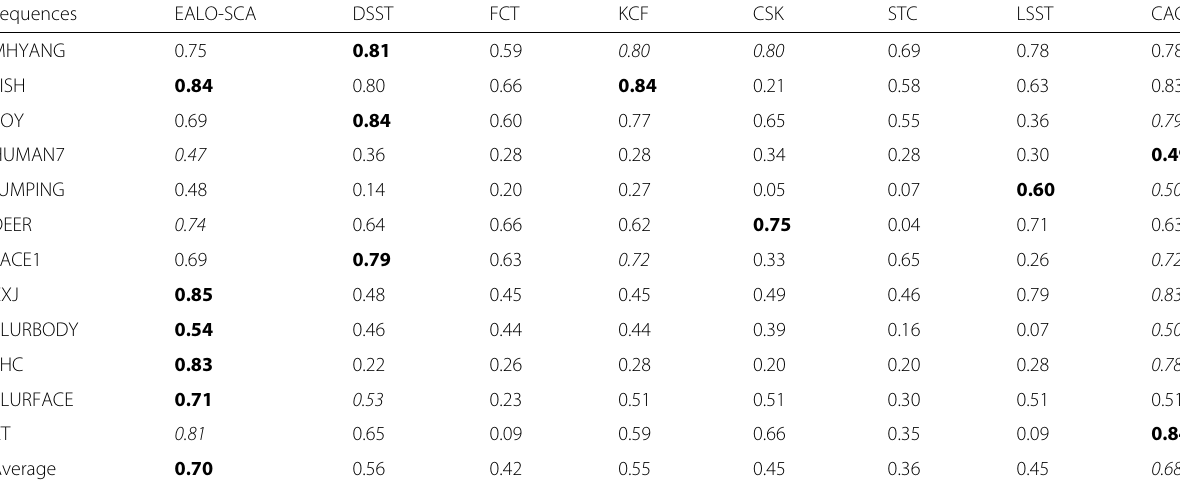
which makes an appropriate trade-off between explo- ration and exploitation for improving tracking perfor- mance. The experimental results show that the algorithm has better tracking performance, especially for abrupt